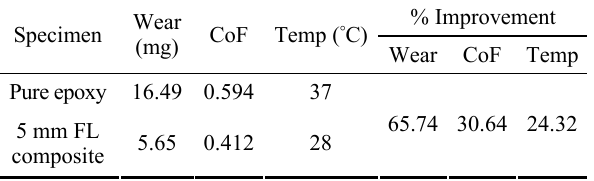
Table 11 Comparison of results at test condition: load 45 N and sliding distance 3,000 m.